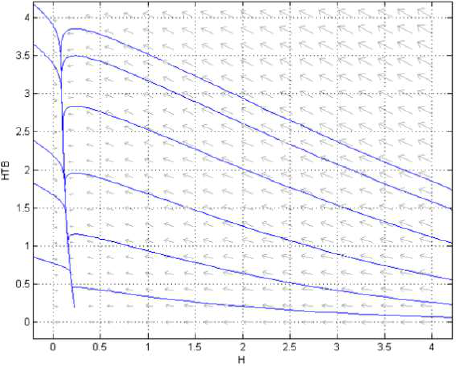
Figure 5. Behavior of H v/s H TB.